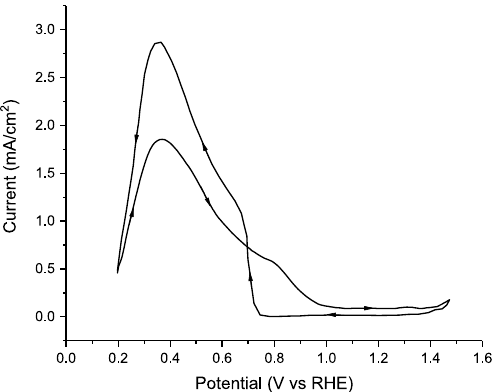
Figure 6. CVs of a planar palladium disk electrode in a solution containing 1.0 M HCOOH + 0.5 M H 2 SO 4 at a scan rate of 70 mV s − 1 . Digitized from Ref. [30].